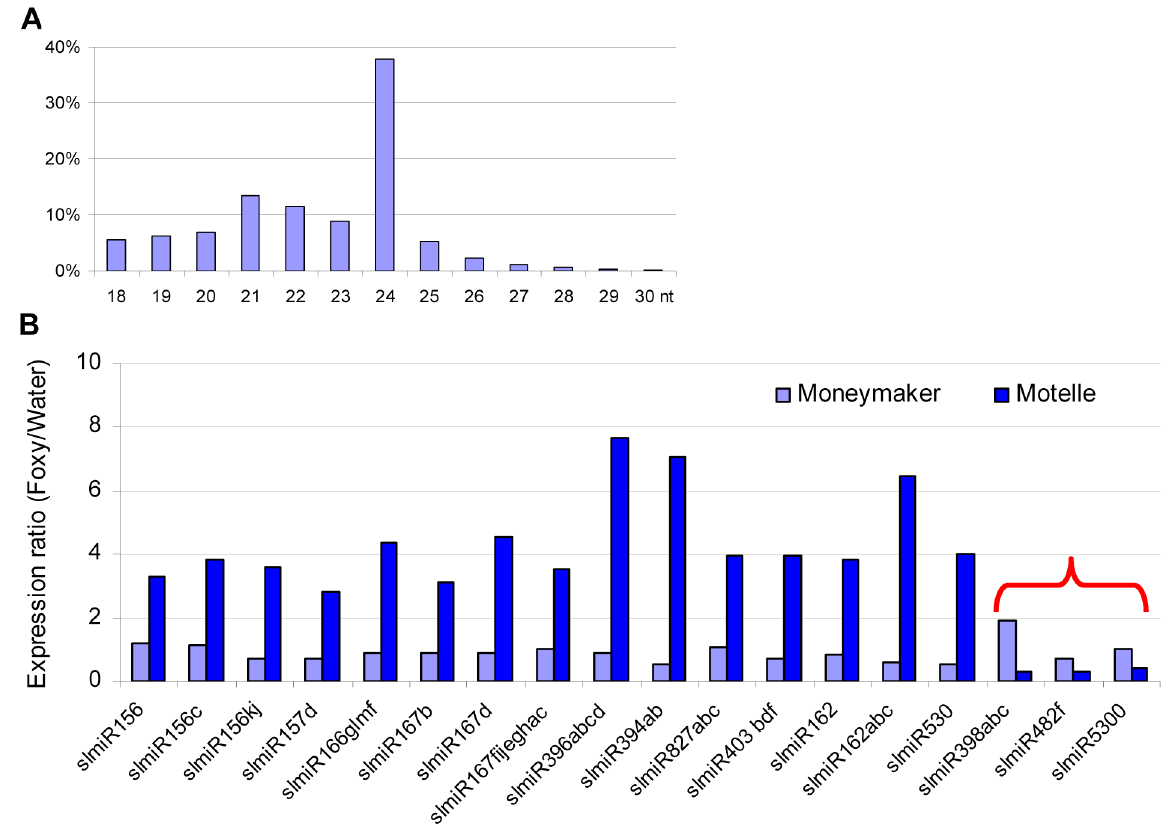
Figure 1. Properties of miRNAs expressed in resistant and susceptible tomato cultivars treated with water or the fungal pathogen Fusariumoxysporum . In total, four small RNA libraries were subjected to deep sequencing: susceptible tomato cultivar Moneymaker treated with water; Moneymaker treated with Fusarium oxysporum f. sp. lycopersici ( F. oxysporum ); resistant tomato cultivar Motelle treated with water and Motelle treated with F. oxysporum . The sequence length of small RNAs ( A ) for the combined data from the four libraries was determined as described in the Materials and Methods. Relative expression levels of known miRNAs ( B ) were determined by dividing normalized reads for F. oxysporum treatment by those for water treatment for each cultivar. The red bracket indicates the miRNAs that were negatively regulated in Motelle, but not Moneymaker, after F. oxysporum infection. Putative roles/targets of miRNAs in various plant species (information from miRBase.org): miR156, miR156c, miR156kj and miR157d: Squamosa-promoter Binding Protein (SBP)-like transcription factors; miR166glmf: HD-Zip transcription factors, including Phabulosa (PHB) and Phavoluta (PHV) that regulate axillary meristem initiation and leaf development; miR167b, miR167d and miR167fijeghac: Auxin Response Factors (ARF transcription factors); miR396abcd: Growth Regulating Factor (GRF) transcription factors, rhodenase-like proteins, and kinesin-like protein B; miR394ab, F-box proteins; miR827abc: Unknown; miR403bdf: Virus defense; miR162 and miR162abc: Unknown; miR530: Unknown; miR398abc: copper superoxide dismutases and cytochrome C oxidase subunit V; miR482f: NB domain proteins; miR5300,